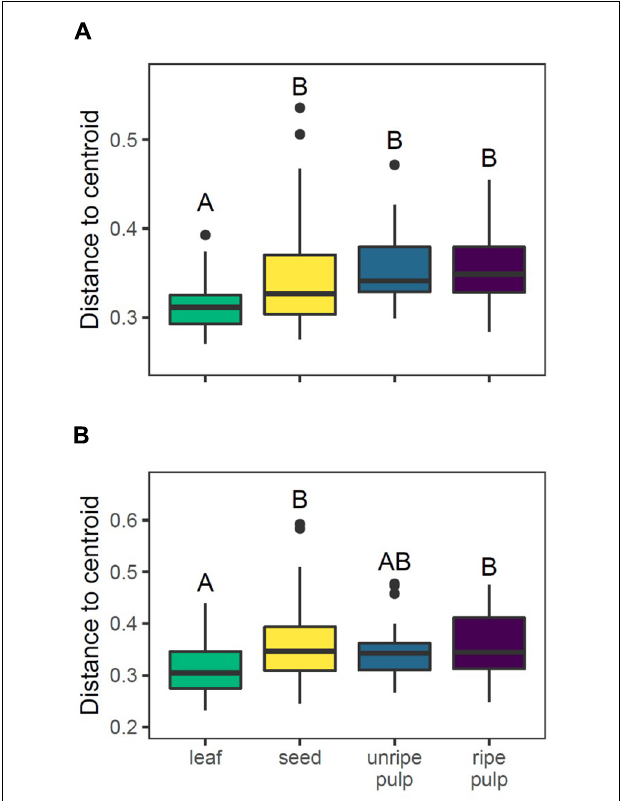
FIGURE 6 | Beta diversity in chemical composition is higher for reproductive organs than leaves when considering variance in compound occurrences (A) or structural composition (B) . Letters indicate results of pairwise Tukey post-hoc comparisons of organs, with non-shared letters indicating a significant difference at P < 0.05.